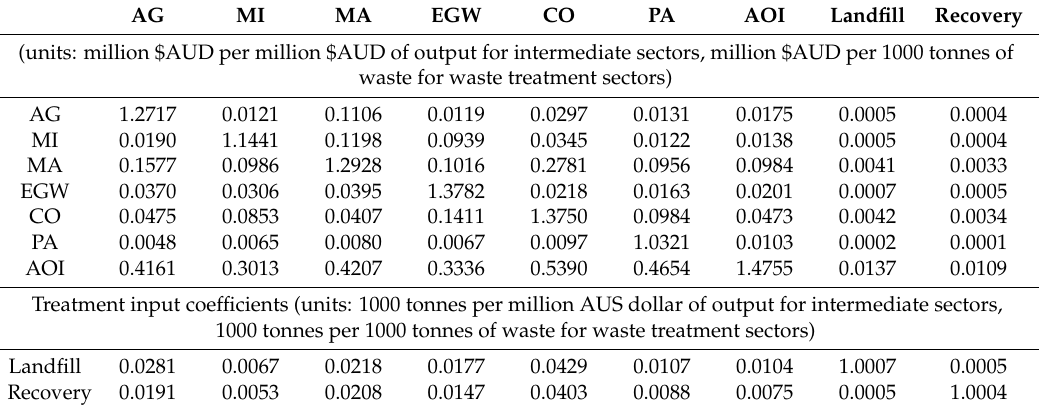
Table 10. The Leontief inverse matrix of the Australian waste input output (WIO) analysis, 2009–2010. AG